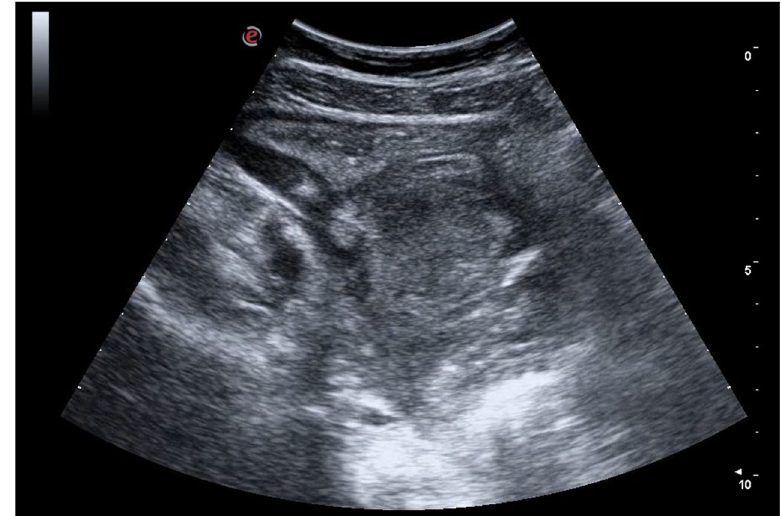
Figure 5. Image obtained with a low frequency convex probe. There is a coarse echogenic formation adjacent to the ileocecal valve which presents a clear wall thickening. Image obtained from a patient with CD who was referred to the emergency room for fever and abdominal pain in the right iliac fossa; final diagnosis of CD acute flare with phlegmon.